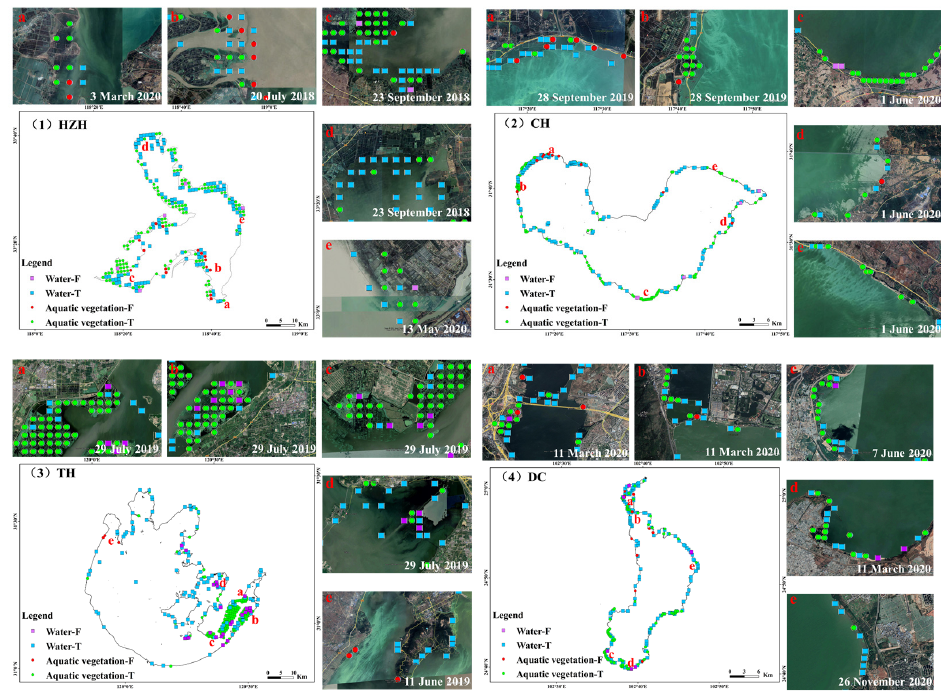
Figure 6. Distribution of validation points and validation results for Lake ( 1 ) Hongze, ( 2 ) Chaohu, ( 3 ) Taihu, and ( 4 ) Dianchi. Five points have been selected in different areas of each lake and their positions in the lake are marked by the letters ( a – e ). The corresponding Google Maps images used for the verification and the results of the verification are shown in the five subimages ( a – e ). The date of the image used for verification can be seen in the bottom right corner of each subimage. Aquatic vegetation-T/F are points within the range of aquatic vegetation. Water-T/F are points within the buffer zone outside the range of aquatic vegetation. T is the point verified as correct. F is points verified as incorrect.